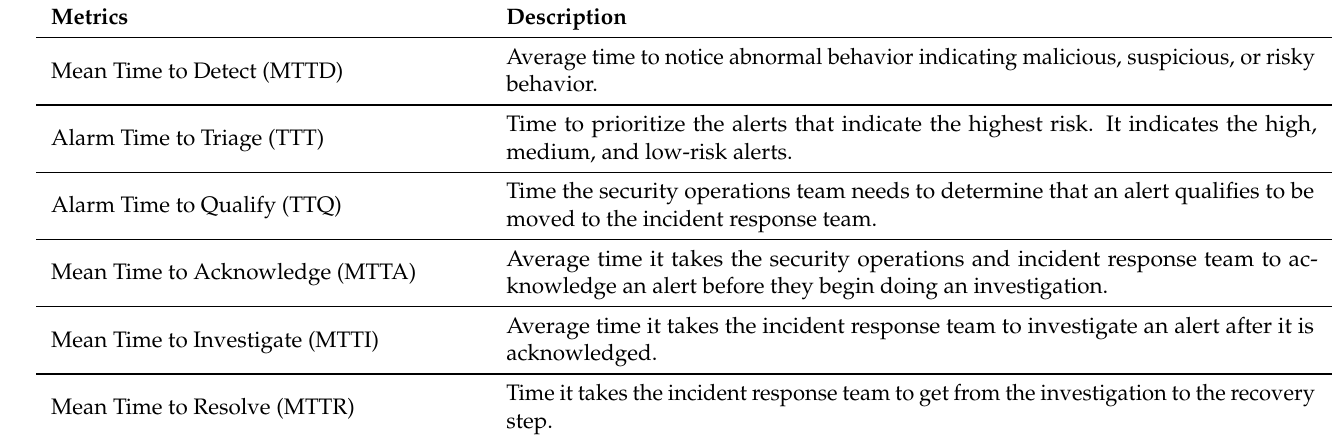
Table 3. On-demand SSLA components (SLO type); key performance Indicators (KPIs) for security operations and incident response